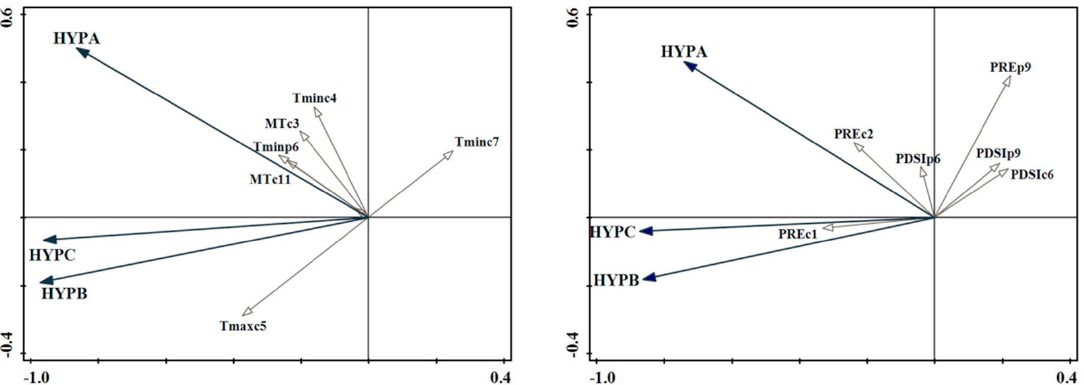
Figure 9. Redundancy analysis of the standard L. principis-rupprechtii chronologies (thick solid line) and monthly climatic factors (thin solid line) at different elevations (1971–2020). HYPA: standard